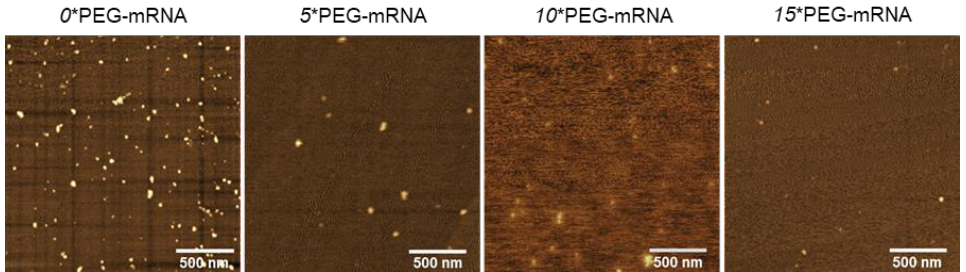
Figure 3. Representative images of AFM observation of n *PEG-mRNA.